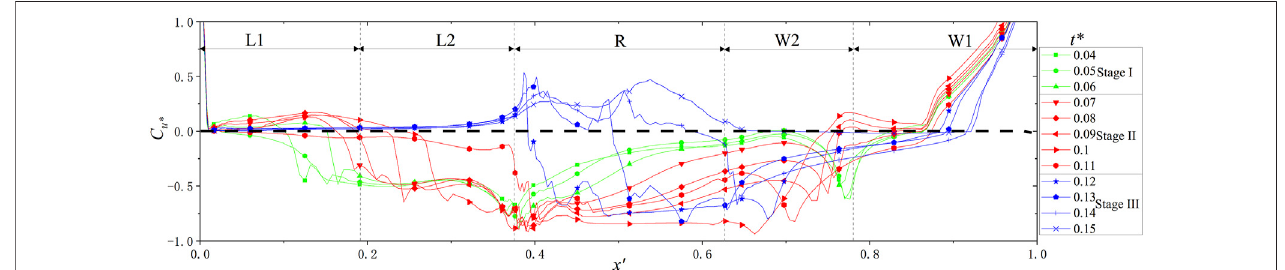
FIGURE 10 | Wall friction velocity at the different stages. Due to the snow erosion deposition model used in this study, The wall friction velocity u* is another critical parameter that is most related to the position of snow accumulation or erosion. The wind speed fl ow fi eld mainly re fl ects the wind speed in the cutting, while the friction velocitynearthewallrepresentsthewindspeedontheground.In Figure9 ,thechangesof u* ineachstagearedescribedindetail,whichisdimensionlessde fi nedas C u* .